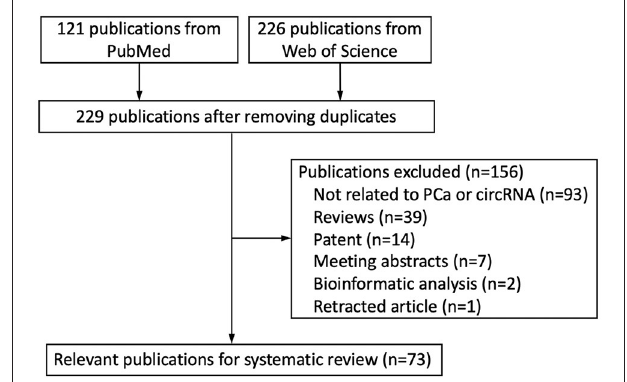
FIGURE 1 | Flow chart of literature